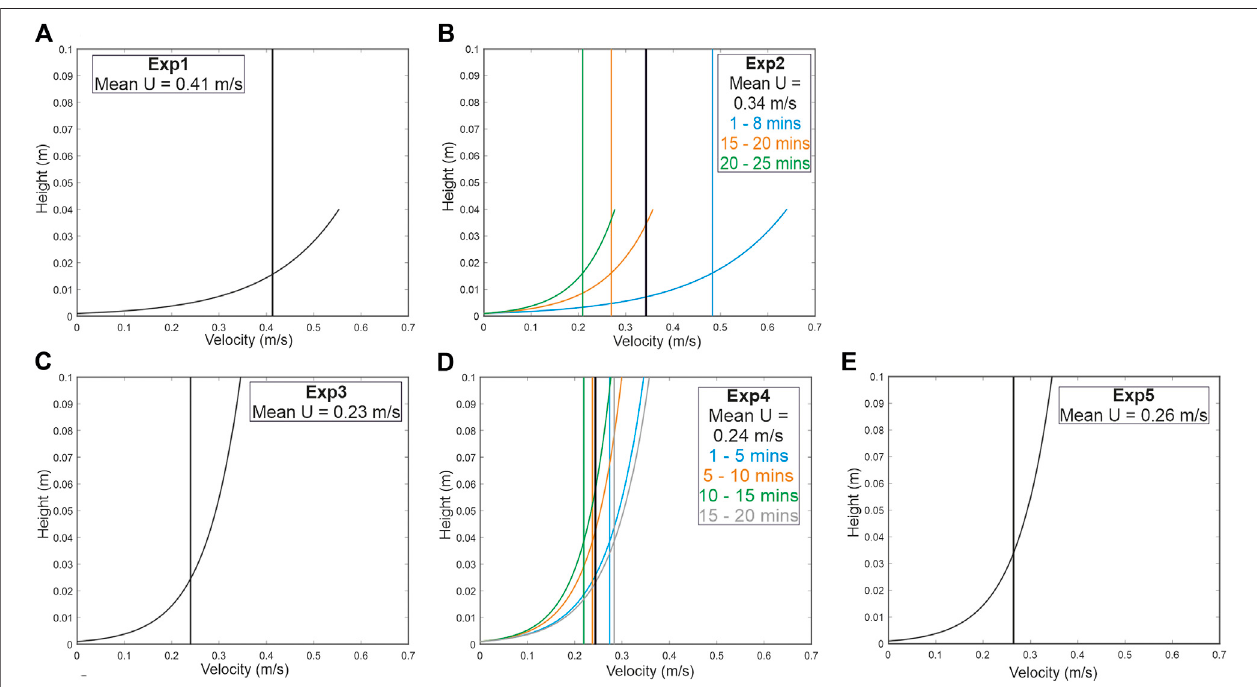
FIGURE 3 | Schematic diagram of asymmetric bedforms. The red points depict the locations the x , y coordinates were recorded on each bedform.